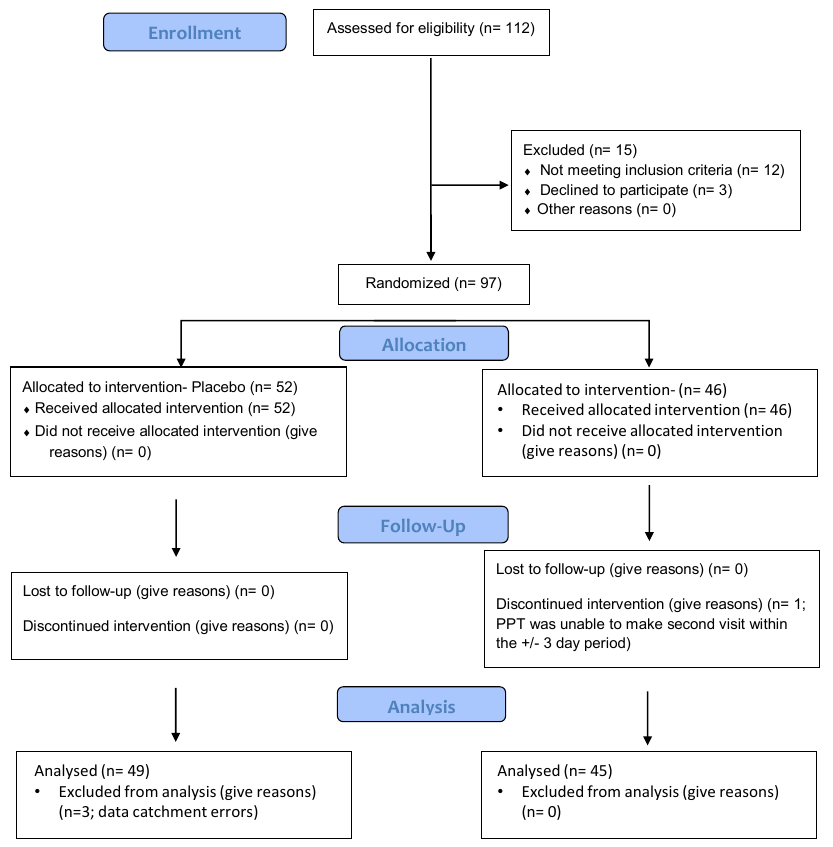
Figure 1. Participant disposition diagram. From the 112 potential volunteers enrolled, 97 were randomised and allocated to receive either treatment A (placebo; n = 52) or treatment B (sage; n = 46). With 1 participant lost to follow up in the latter group and 3 excluded from analysis due to data catchment errors in the former group, the final total of data sets available for analysis were n = 49 in the placebo condition and n = 45 in the sage condition.